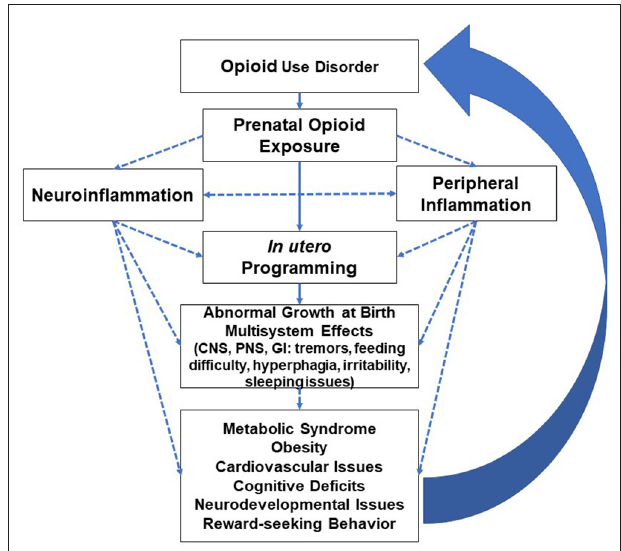
FIGURE 2 | Inflammatory modulation of opioids and multiorgan effects with long-term adverse effects leading to increased predisposition to opioid use disorder (CNS = central nervous system, PNS = peripheral nervous system, GI = gastrointestinal system). Well-studied or known topics are indicated by solid lines; hypothetical topics or knowledge gaps are indicated by dashed